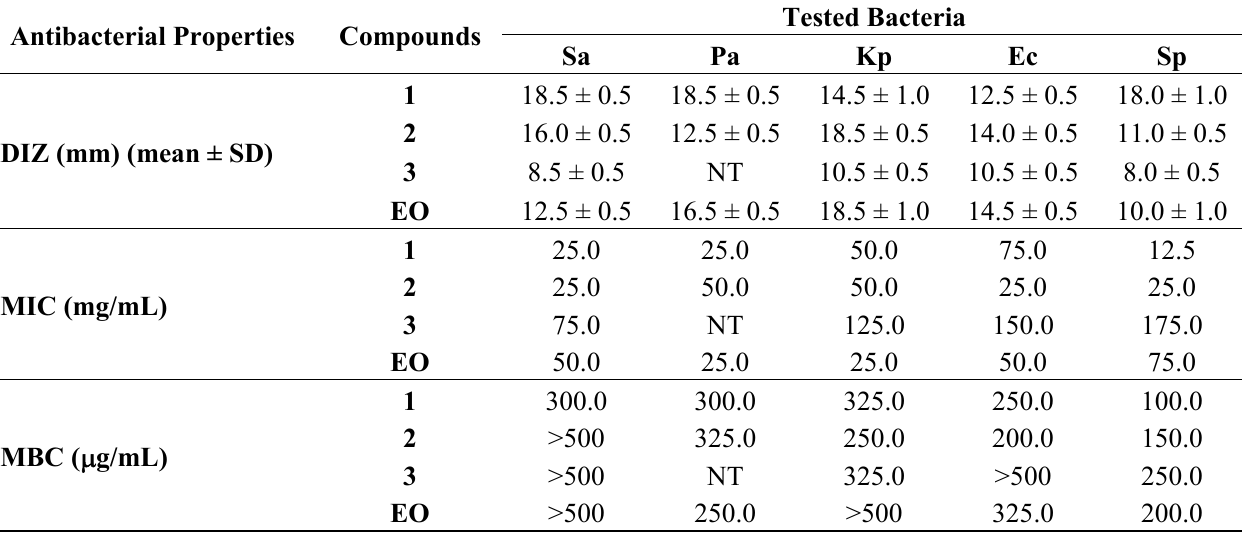
Table 3. Antibacterial properties of mahanine ( 1 ), mahanimbicine ( 2 ), mahanimbine ( 3 ) and essential oil tested on five strains of clinical human